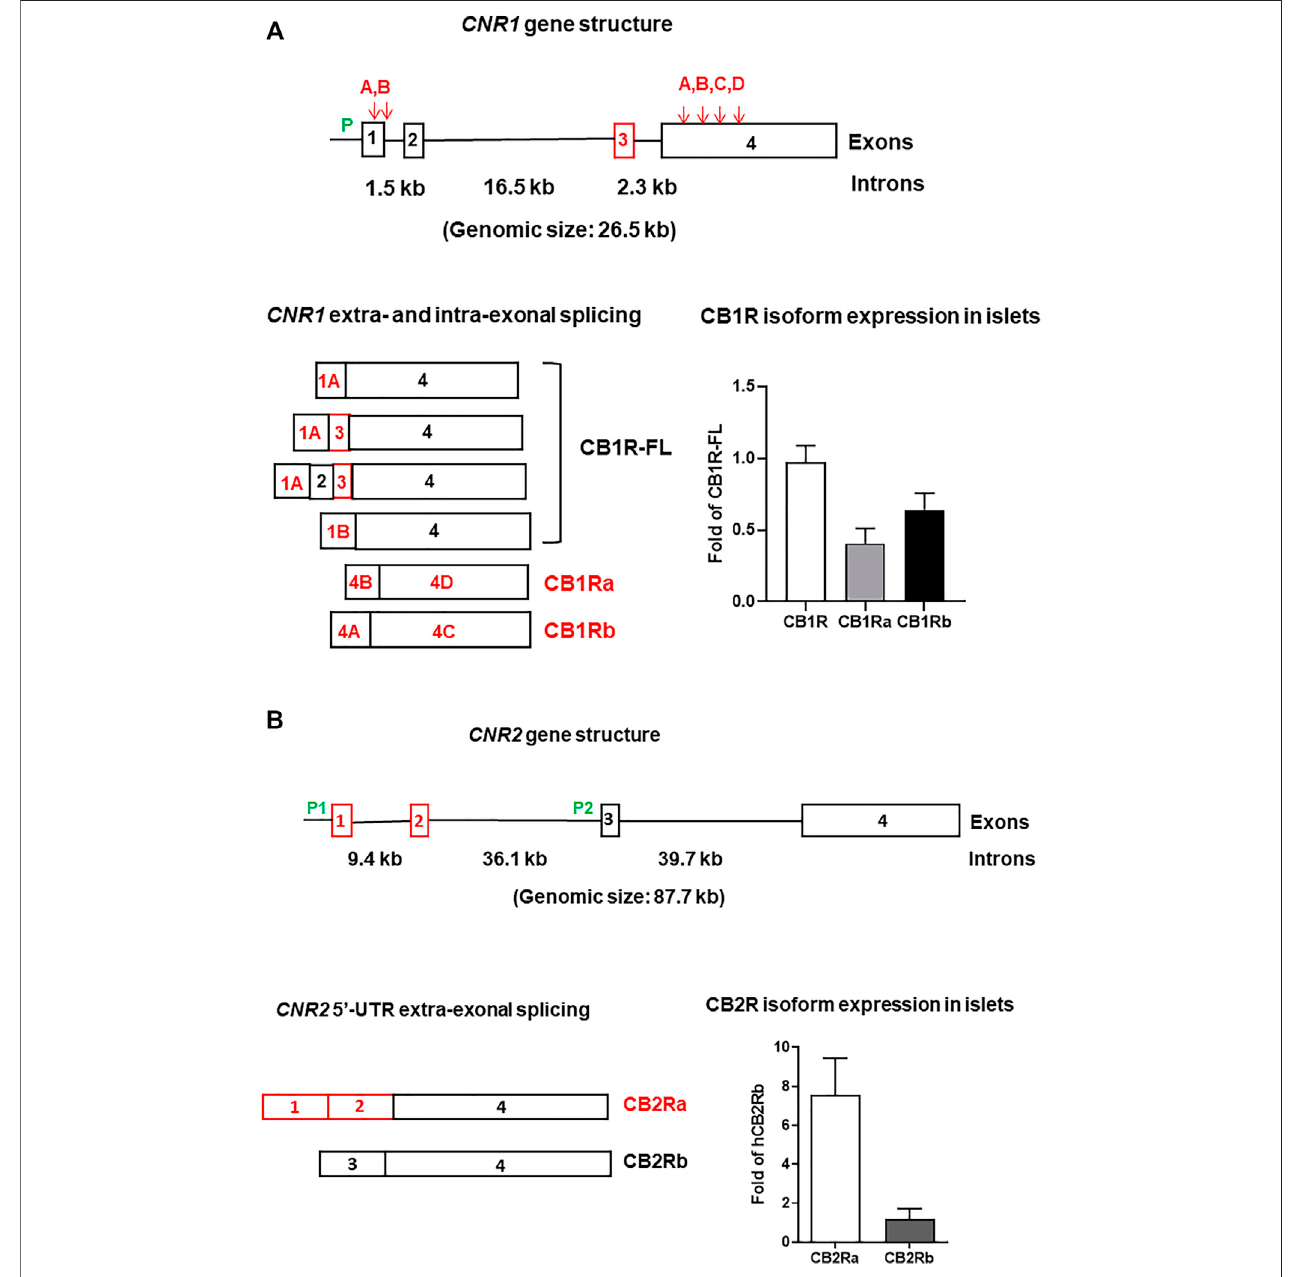
FIGURE 2 | Human CNR1 (A) and CNR2 (B) gene structures, their alternatively spliced isoforms, and expression in pancreatic islets. P (green lettering) represents promoters. Exons are open boxes and introns solid lines. The exon numbers are inside the open boxes and intron sizes are marked in kb (kilobase). Downward arrows and capital letters are at the intra-exonalsplicing sites. Red letterings, boxes, and arrows represent human speci fi c isoforms, exons, and splicing sites, respectively. The reference ofCB1R isoform islet expression (n (cid:1) 6) is full-length CB1R (CB1R-FL)and the reference of CB2R isoform islet expression (n (cid:1) 3) is CB2Rb (unpublished data from Diabetes Section,